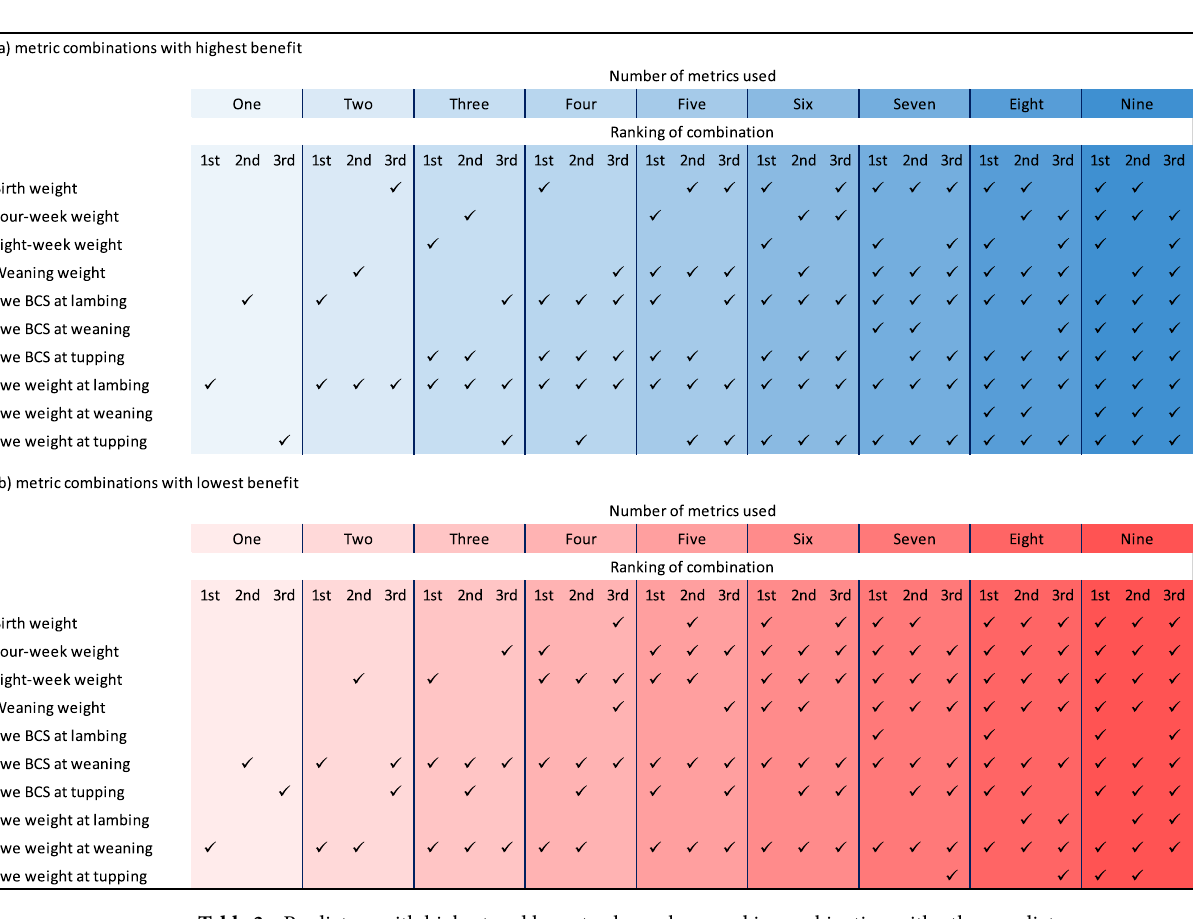
Table 3. Predictors with highest and lowest values when used in combination with other